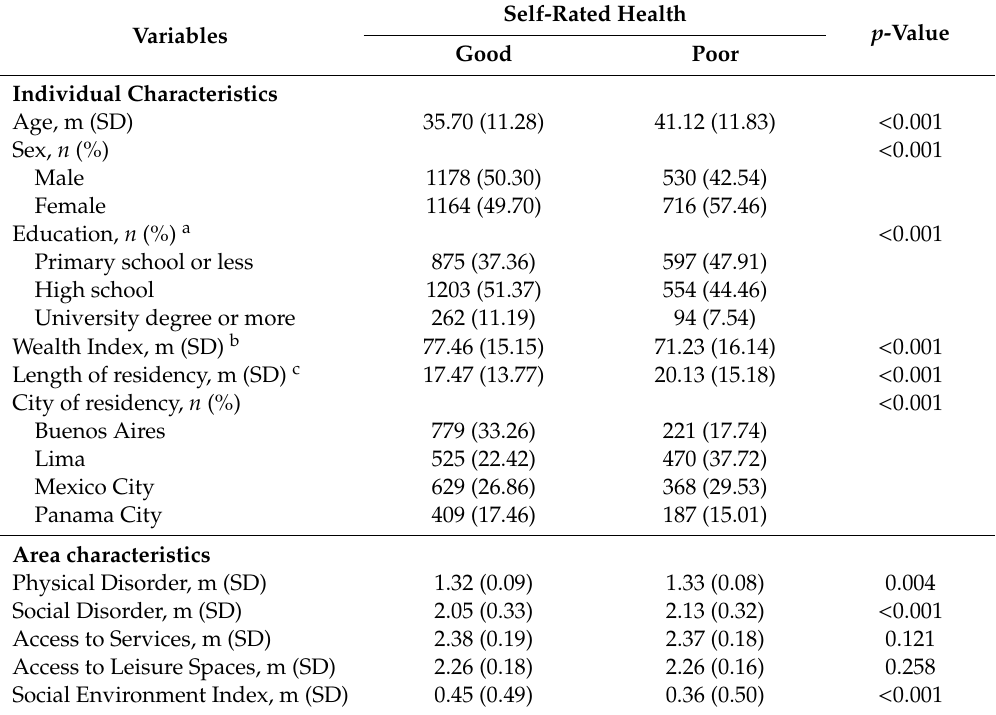
Table 2. Individual and area characteristics by self-rated health status CAF Survey, 2016–2017. Variables p -Value